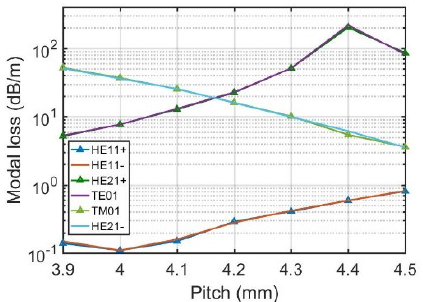
Figure 3. Modal losses of a twisted octagon-shaped core fiber versus Λ with R = 25 μm, NA = 0.065, and λ = 1064 nm, Λ in the range of 3.9–4.5 mm. and λ = 1064 nm, Λ in the range of 3.9–4.5